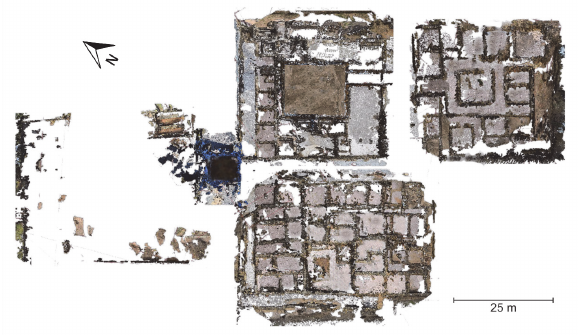
Figure 5. Nadiral view of the dense point cloud.